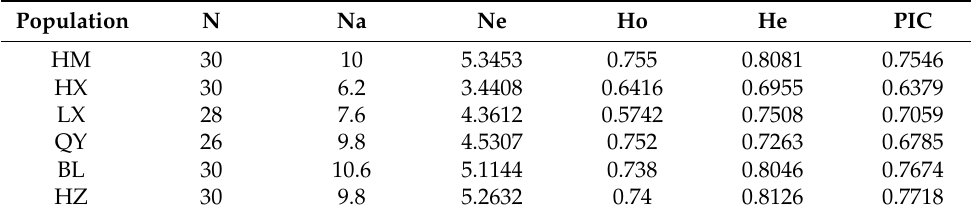
Table 2. Summary statistics for the 5 microsatellite loci.